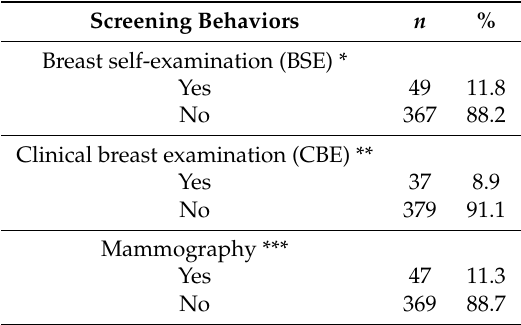
Table 2. Breast cancer screening behaviors of the participants ( n = 416).